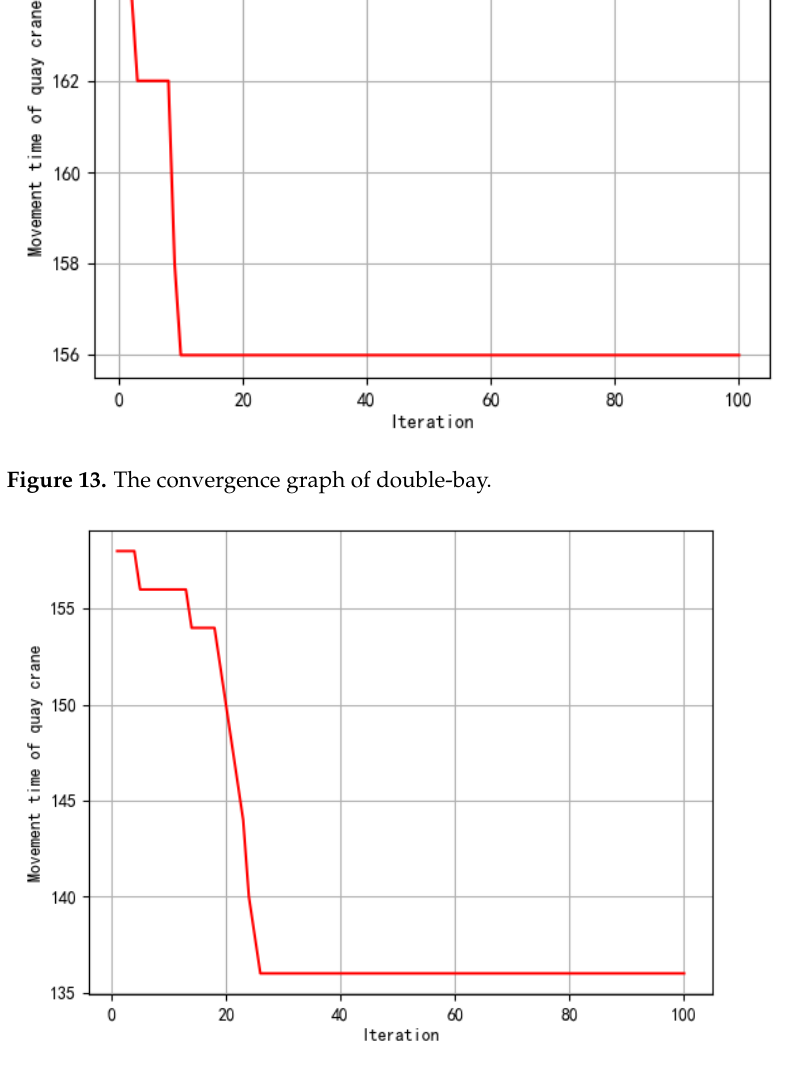
Figure 14. The convergence graph of the single bay. Table 10. Results after increasing the number of